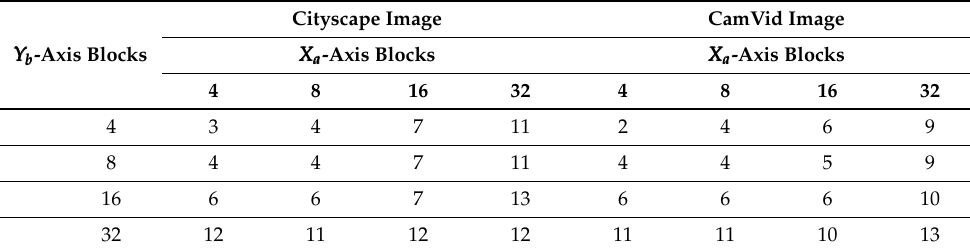
Table 1. Number of representative areas generated by each dataset.